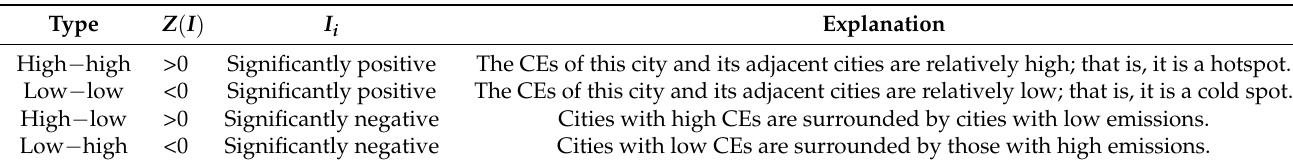
Table 2. Four types of local spatial